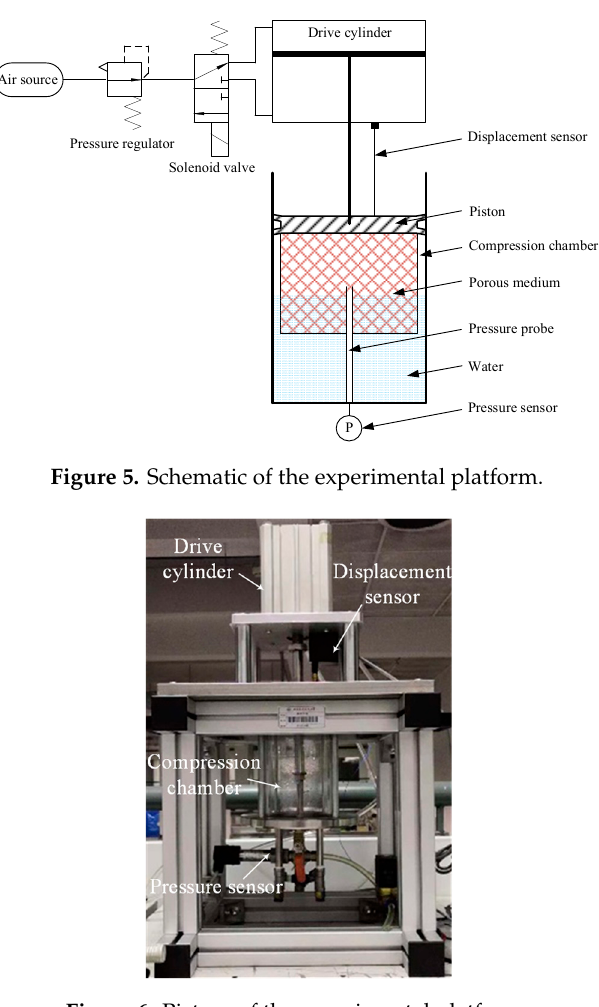
Figure 6. Picture of the experimental platform.